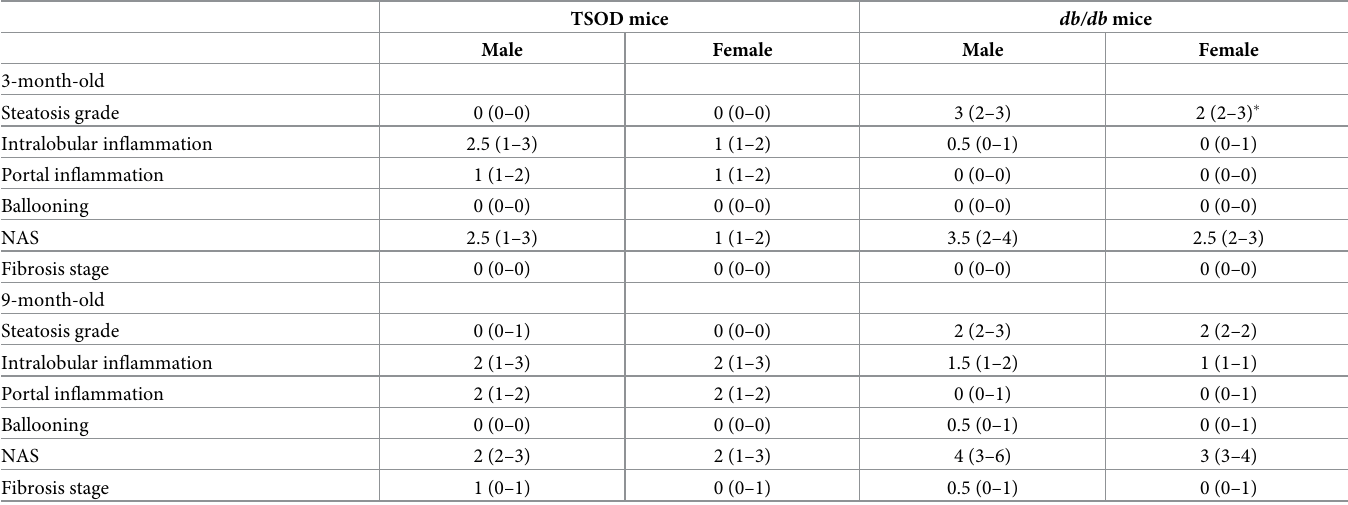
Table 4. Histopathological findings.